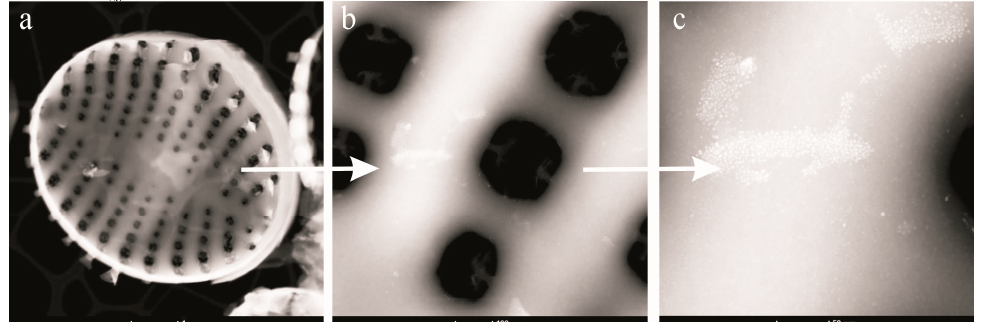
Figure 3. TEM micrographs of the palladium(II) chloride-doped diatom biosilica photocatalyst. Ordered periodic pore system ( a ), the morphology and structure of periodic pores ( b ), and the size, forms and specificity of the distribution of immobilized palladium(II) chloride nanoparticles ( c ).